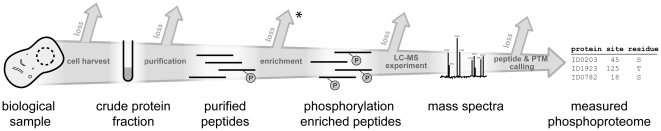
Outline of a high-throughput mass spectrometry based phosphoproteomics workflow.The horizontal arrow represents the number of phosphosites under analysis; the smaller arrows represent phosphosites lost at specific steps of the workflow. The arrow marked with a * (phosphosites not measured because they are lost in the enrichment phase) is discussed in more detail in the main text.